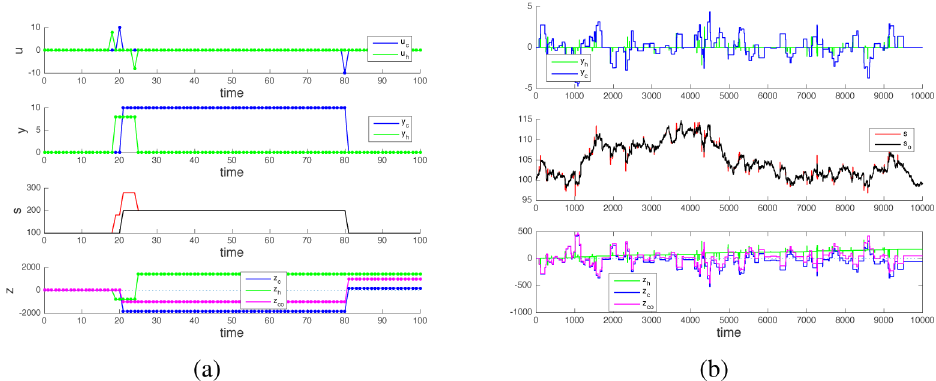
Fig 8. Front-running an order. A high-frequency trader that can anticipate the operations of a slower classical trader can benefit of the price impact created by the latter, in addition to the one induced by his own trades. In the top plot of both panels, the high-frequency trader input u h (green) always precedes the moves of the classical trader ( u c , blue). In the plot for s of both panels the black trace (denoted s o ) represents the stock quote in absence of high frequency trader, while the red trace ( s ) is the stock quote in presence of a front- running high-frequency trader. The geometric phase (and hence any possible profit) tends to swap from the classical trader to the high-frequency trader. For the classical trader, the profit in presence of a front-runner is reduced (blue curve in the lower plot of both panels, denoted z c ) with respect to the same curve in absence of front-run (magenta curve, denoted z c o